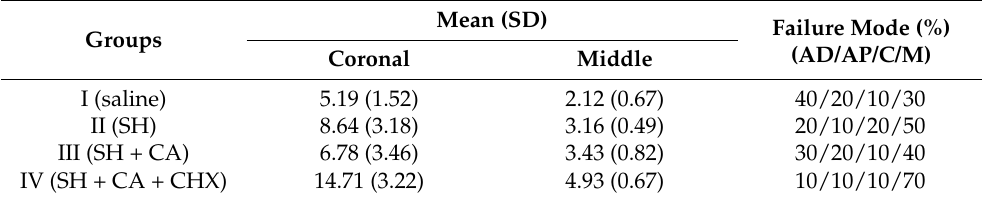
Table 1. Mean (MPa) push-out bond strength values (standard deviations) of each irrigating solution and failure mode distribution